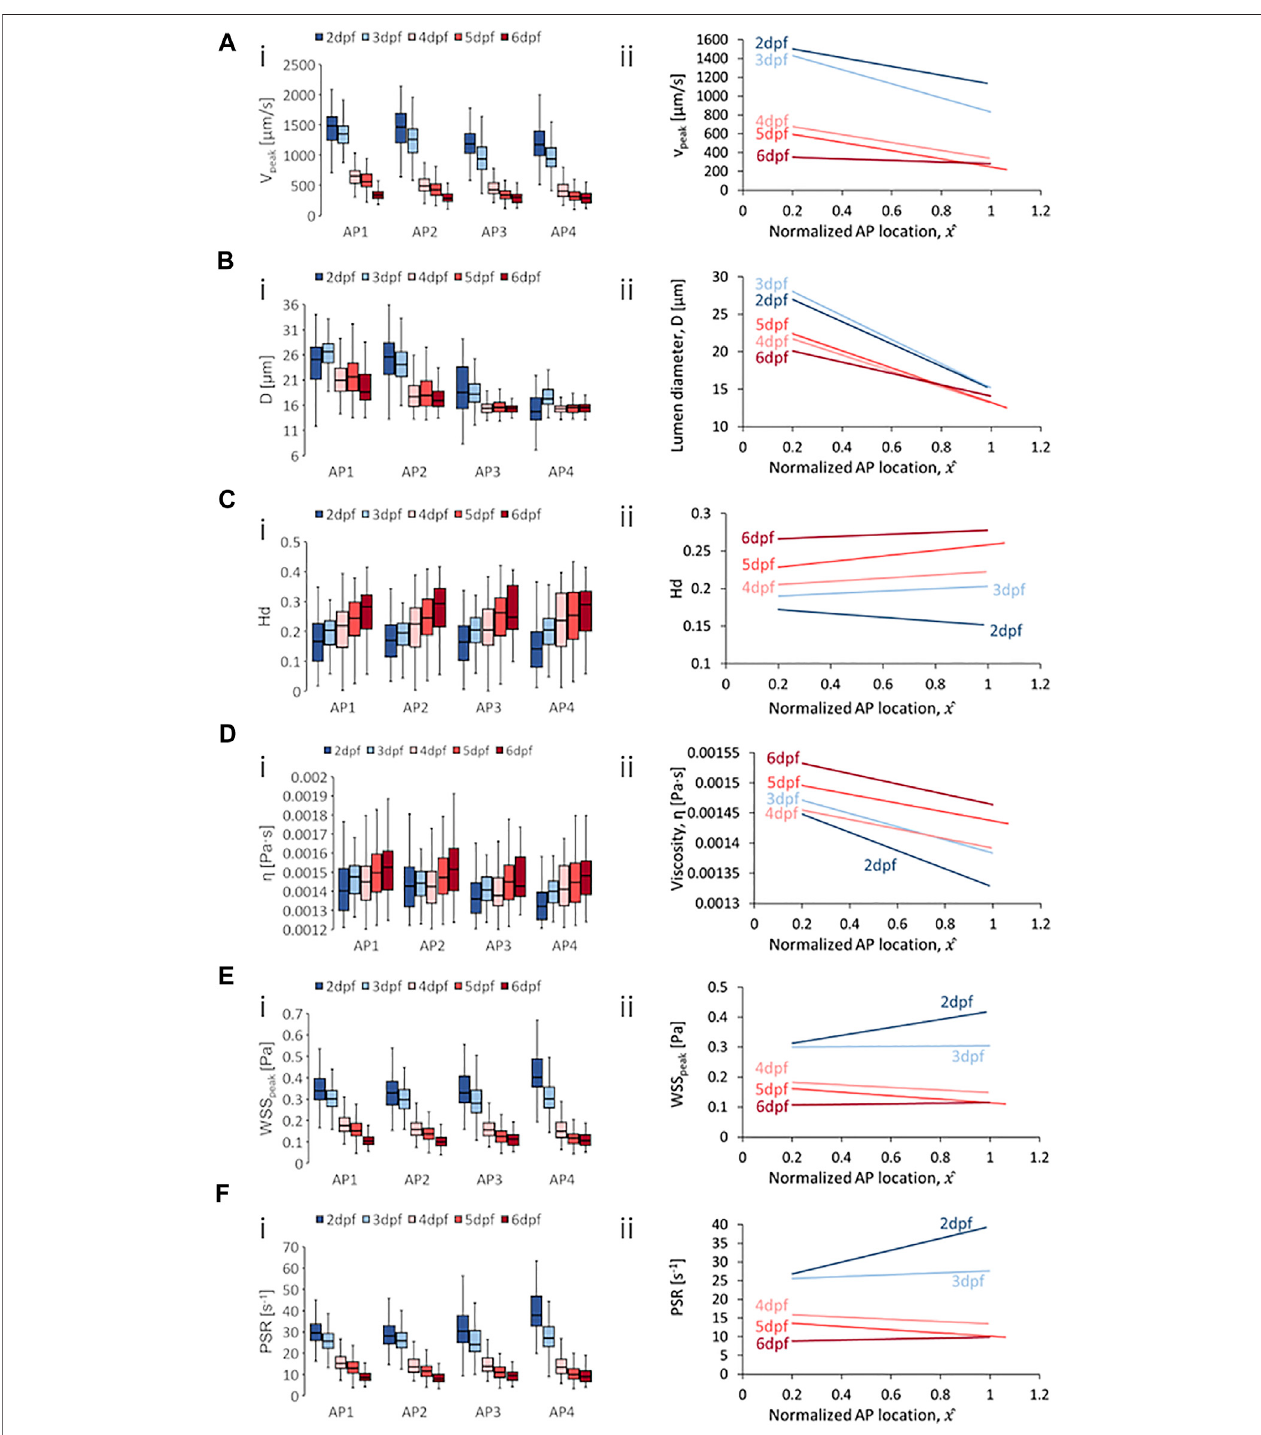
FIGURE 5 | Developmental trends of morphological and hemodynamic quantities in the posterior cardinal vein/caudal vein plexus (PCV/CVP). (A) The changes in V peak atfourregionsalongtheanterior-to-posterior(AP)axis (i) andtheAPtrendfor V peak (ii) . (B) Thechangesin D atfourAPregions (i) andtheAPtrendfor D (ii). (C) The changes in H d at four AP regions (i) and the AP trend for H d (ii) . (D) The changes in η at four AP regions (i) and the AP trend for η (ii) . (E) The changes in WSS peak at four APregions (i) andtheAPtrendfor WSS peak (ii) . (F) Thechangesin PSR atfourAPregions (i) andtheAPtrendfor PSR (ii) .Boxplotsin (i) ofPanels (A – D) showthe medianandthe fi rst(Q1)andthird(Q3)quartilelevelsofthehemodynamicquantityforthepooledzebra fi shdata.Thewhiskerbarsrepresentthemaximumandminimum ranges of the data that lie within 1.5 times of the interquartile range (IQR = Q3 − Q1) beyond Q1 and Q3.